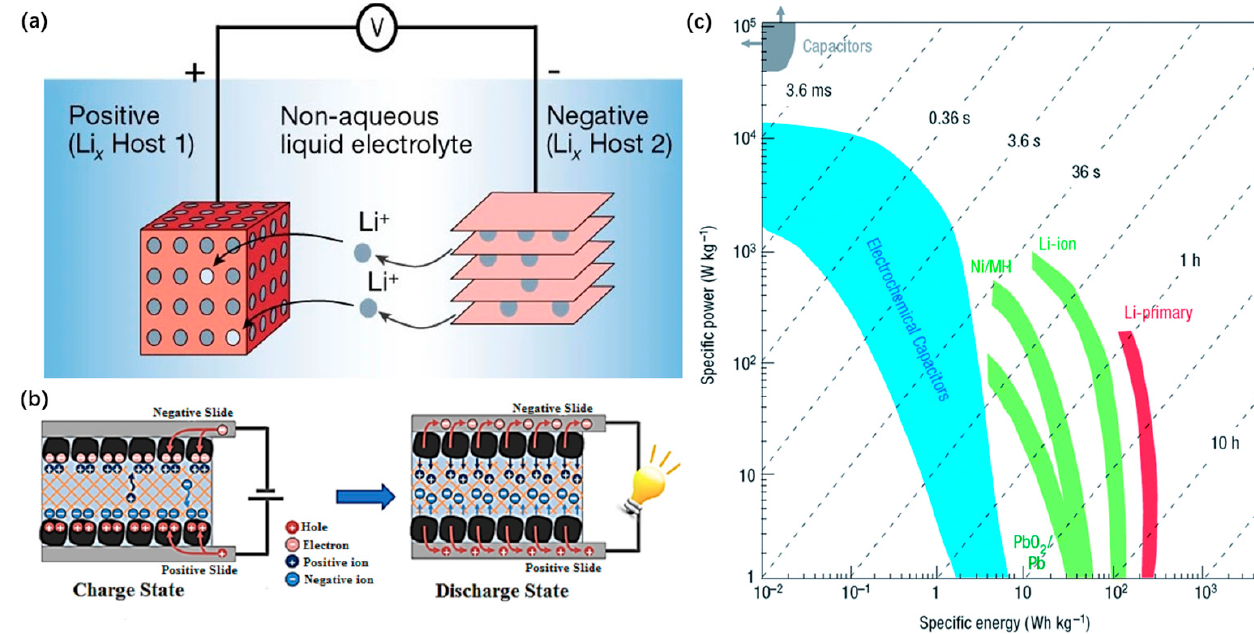
Figure 5. ( a ) Schematic diagram of a rechargeable lithium-ion battery [61]; ( b ) Charging and dis- charging states of supercapacitors [24]; ( c ) Specific power density against specific energy density, also called a Ragone plot, for various electrical energy storage devices